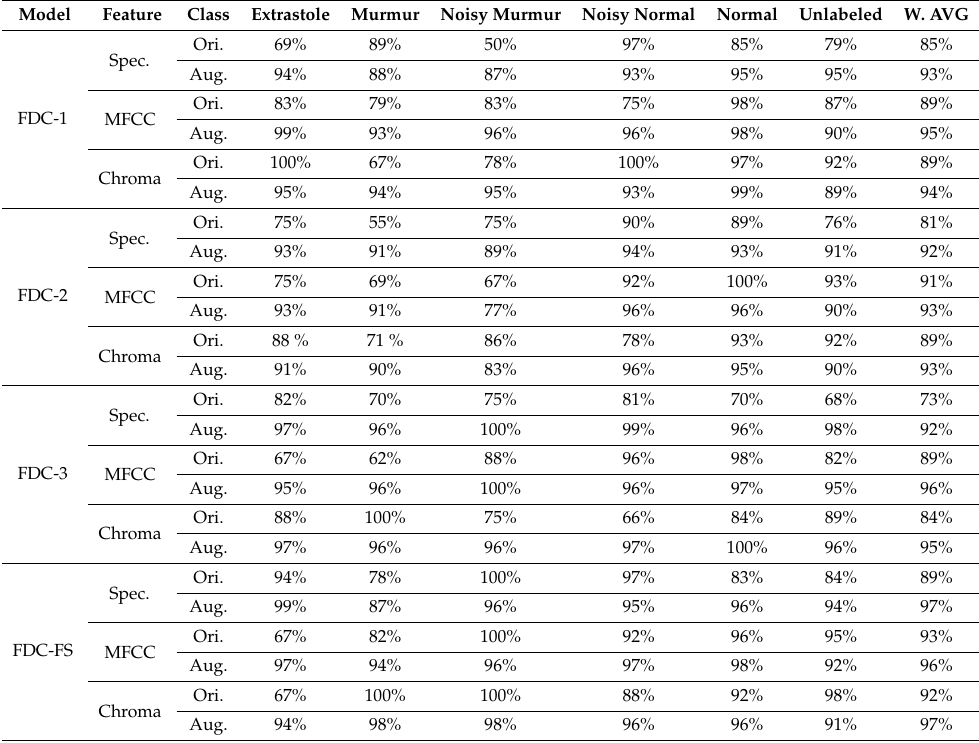
Table 11. Class Wise Accuracy for Heart Condition Detection.